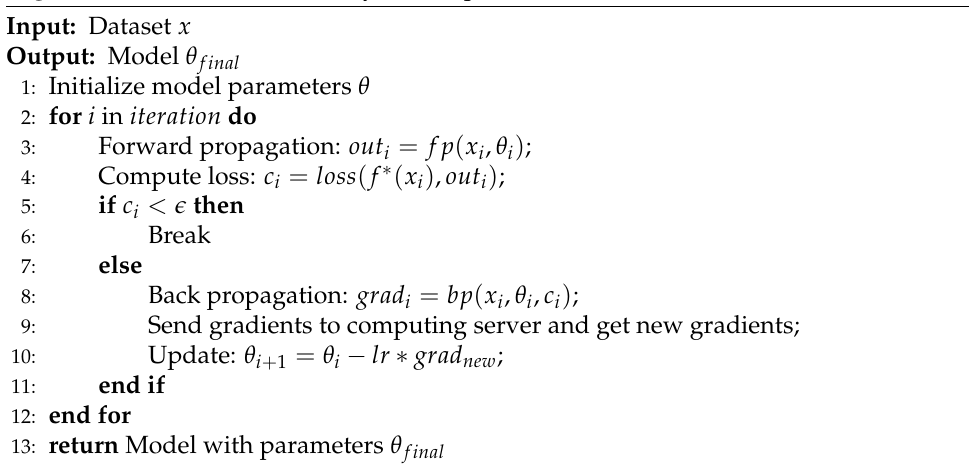
Algorithm 1 Federated Multi-Layer